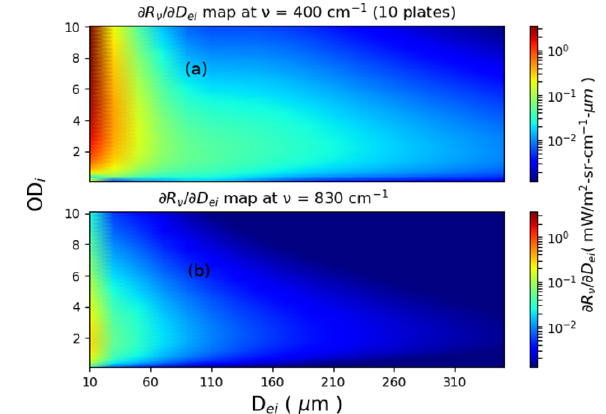
Figure 7. Color map of the same derivatives of Fig. 6, but only for the 10 plates aggregate and for multiple optical depth values ranging between 0.1 and